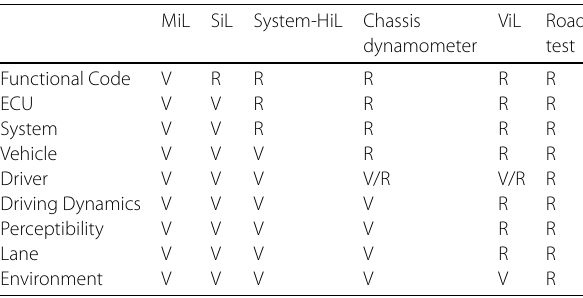
Table 1 Overview of testing advanced driver assistance systems in simulation (virtual) and in reality. V: Virtual, R: Reality [12] MiL SiL System-HiL Chassis ViL Road dynamometer